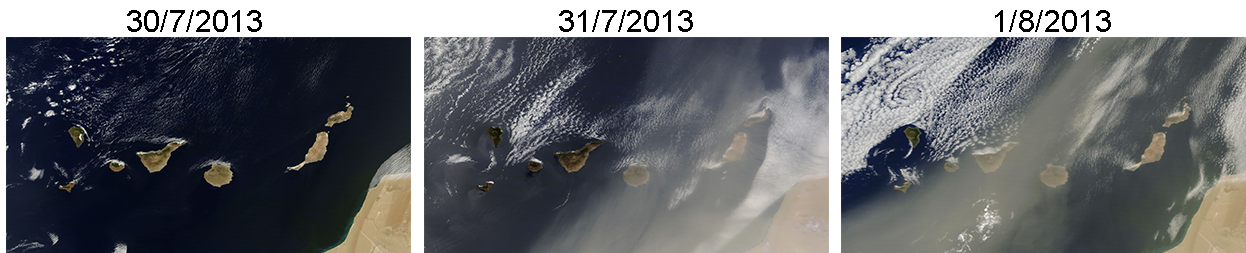
Figure A1. Images for the Canary Islands on three consecutive days (130730, 130731, and 130801). Images are daily composites of data of the Moderate Resolution Imaging Spectroradiometer (MODIS) aboard the NASA Terra and Aqua satellites. Source: https://earthdata.nasa.